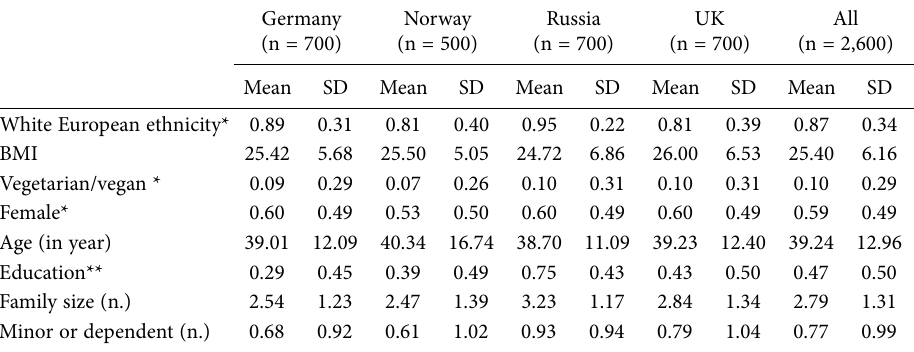
Table 2. Summary